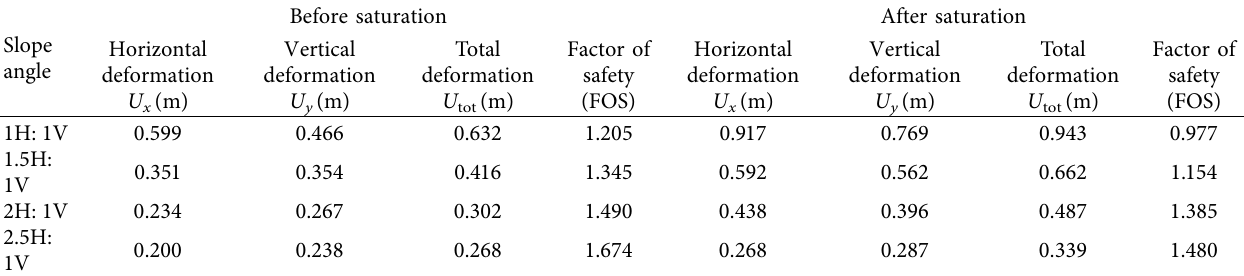
Table 5: FOS and slope deformation values for slope-4 by Plaxis 2D before and after saturation. Before saturation After saturation Slope Horizontal angle deformation safety